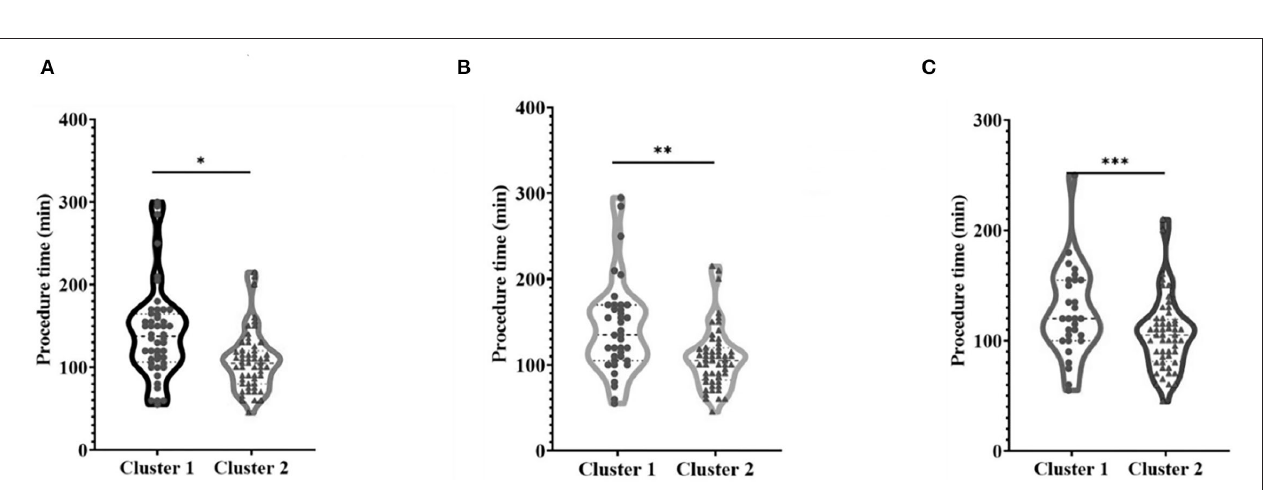
FIGURE 4 | Representative images of CVO recanalization in cluster 1 and cluster 2. (A) Computed tomography of (CT) reconstruction of long segmental occlusion exceeding 2cm with blunt stump and calcification in the right brachiocephalic vein; (B) venography shows multiple collateral circulations around the occlusion; (C) venography showing unobstructed blood flow in the right brachiocephalic vein after covered stent placement; (D) CT reconstruction of stenosis < 2cm in the right subclavian vein without calcification and blunt stump; (E) venography showing stenosis without collateral circulation within 1cm; (F) venography showing unobstructed blood flow in the right subclavian vein after covered stent placement.